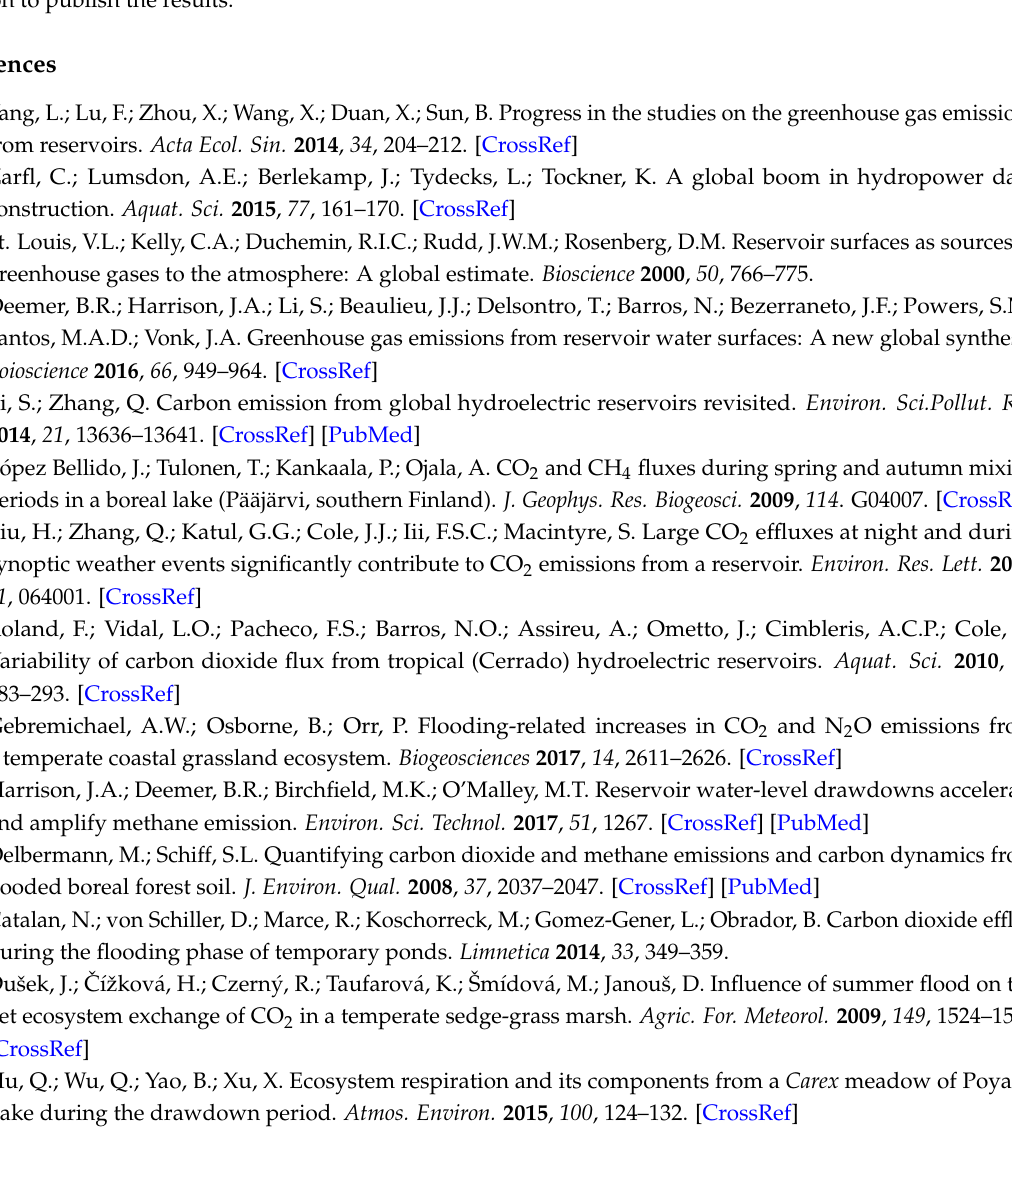
Figure S1: Environmental characteristics (Mean ± SE) of each sampling area; Figure S2: Simulated flux of each area of the sampling growing season; Table S1: Dominant plant species at each plot in different months; Table S2: Spearman’s Rank Correlation ( r ) between flux and environmental variables.; Table S3: CO2 flux from open water areas of reservoirs around the